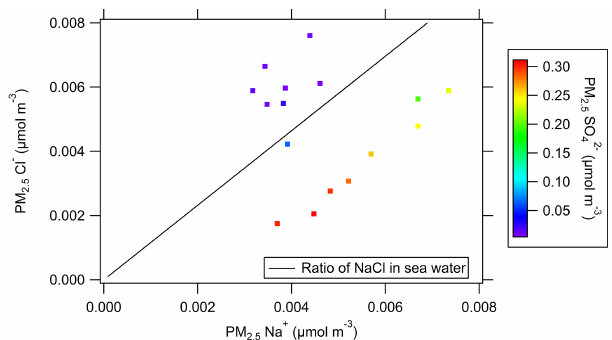
Figure 7. Evidence of acid displacement in sea salt (PM 2 . 5 ) on 21 September 2014 from 00:00 to 18:00 (GMT) at Auchencorth Moss where the solid line is the known ratio of NaCl in sea water (Sein- feld and Pandis,